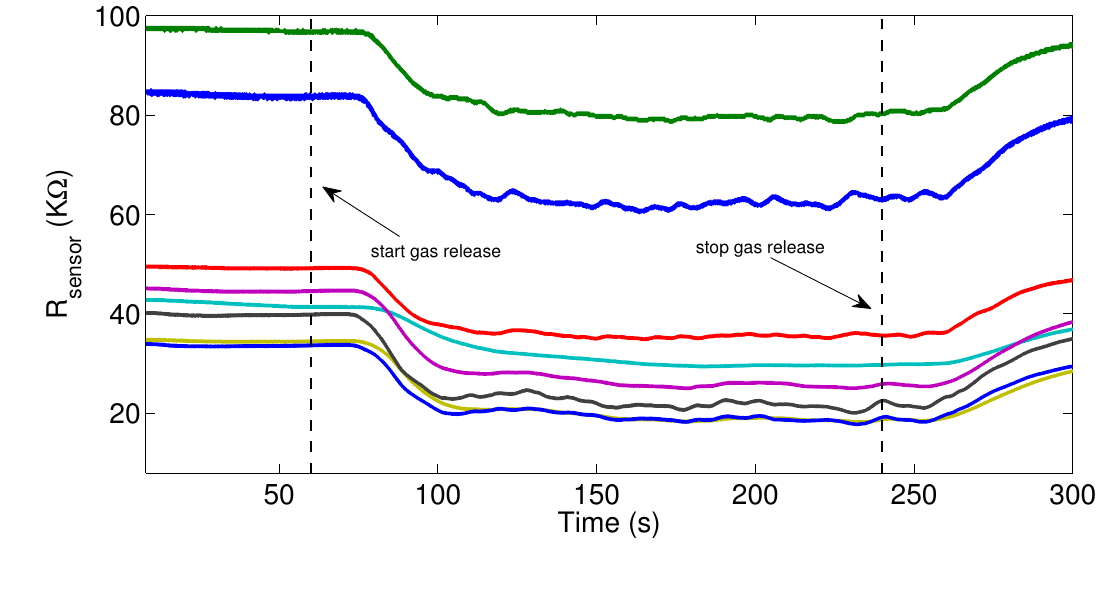
Figure 3. Signals acquired from the sensor unit when being exposed to a dynamic mixture of ethylene and CO. Gas release started at t duration of the experiment was 300